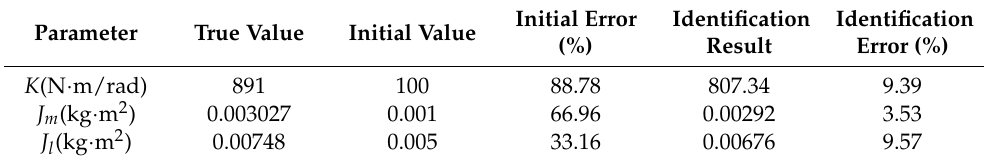
Table 4. Identification results of the three parameters.